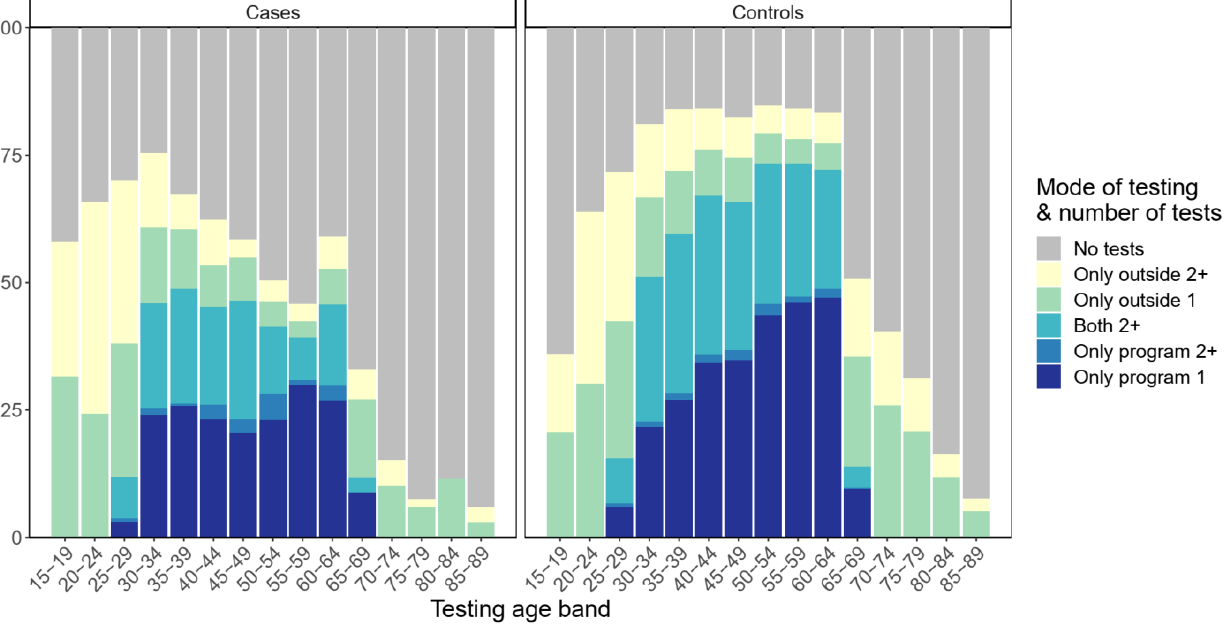
Figure 2. Test coverage and intensity by five-year testing age bands. Cases’ diagnoses occurred in the following five-year age band.